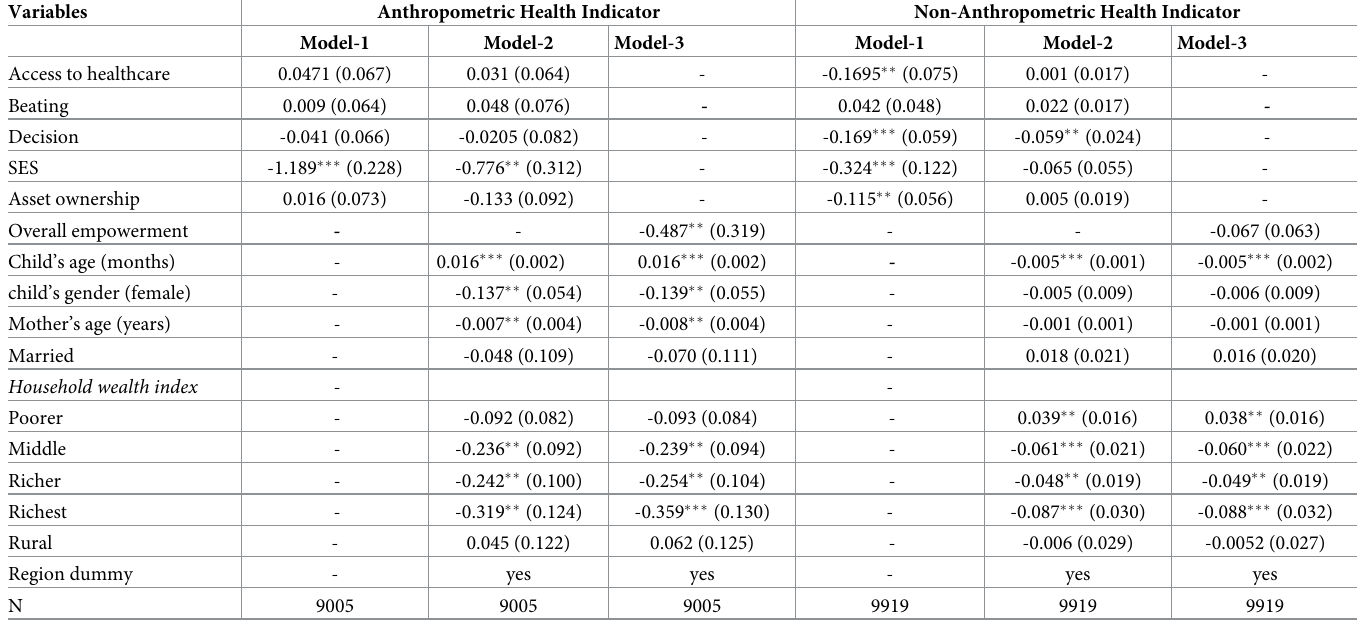
Table 3. Results of the structural component of the MIMIC